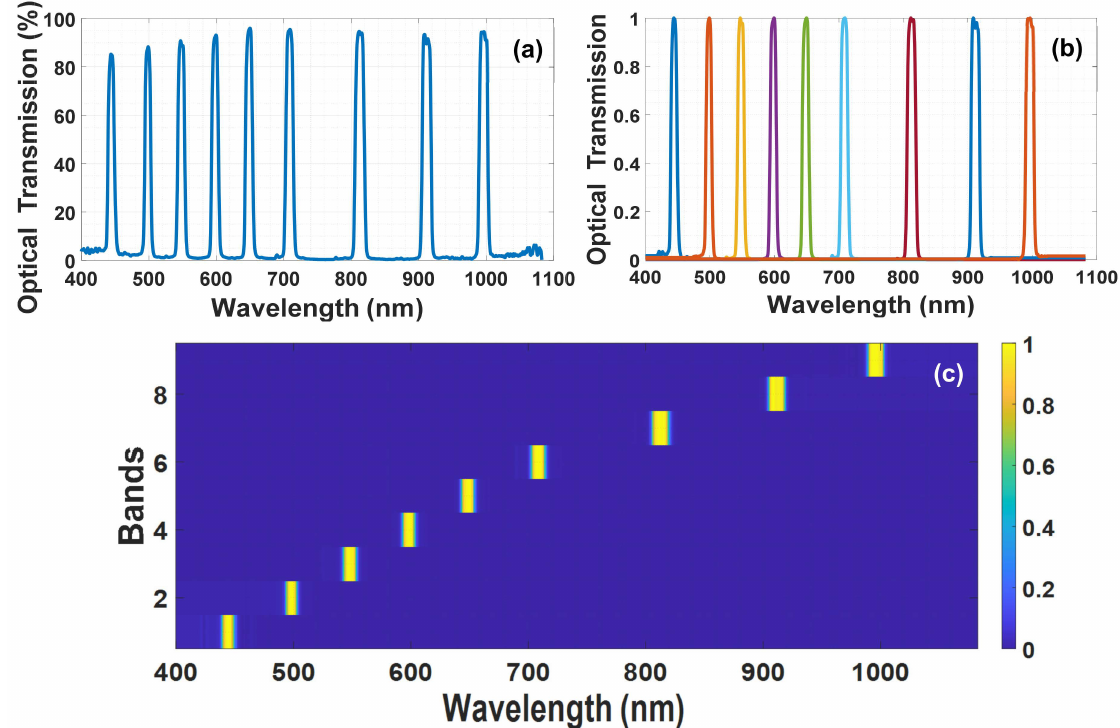
Figure 11. ( a ) This graph shows the spectral transmission of a multi-channel spectral passive filter. The filter can be designed to transmit the wavelengths according to the specific application. ( b ) This figure depicts the breaking of the spectral transfer function of the filter to a set of spectra that can form any spectral signal which will pass through the filter. It should be noted that the spectral filter contains 9 spectral windows and now this is displayed as 9 different spectra (in different colors) that together form any spectral signal that reaches the detector. ( c ) Transpose matrix transition from channel weights to spectrum, in other words this is the matrix form of ( b